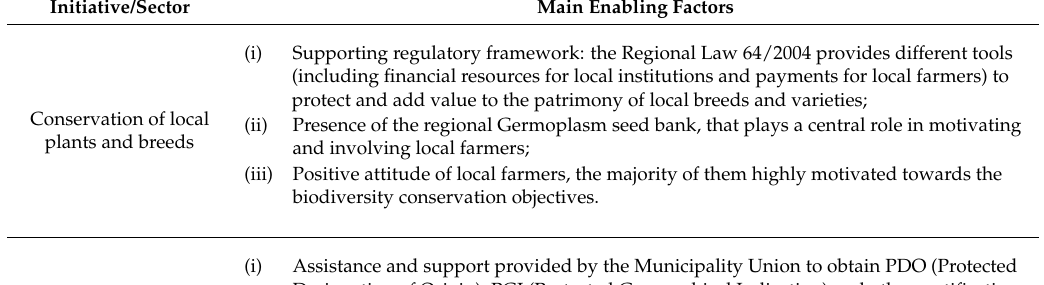
Table 2. The most relevant initiatives related to the Localized Agri-food Systems (LAFS) in Garfagnana.